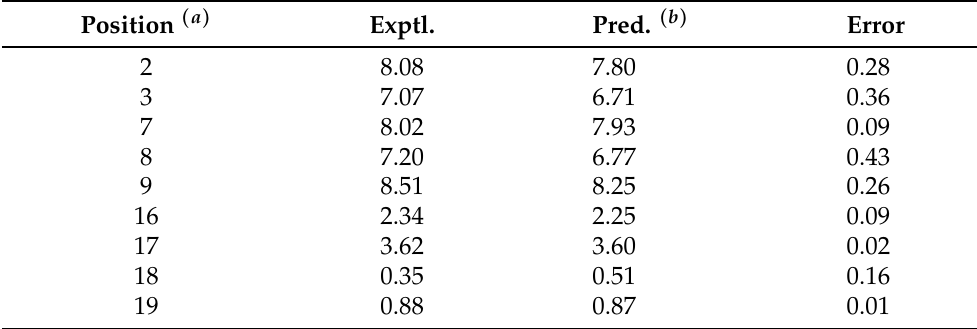
Table 2. Predicted and experimental 1 H NMR chemical shifts (in ppm) of Nevirapine.